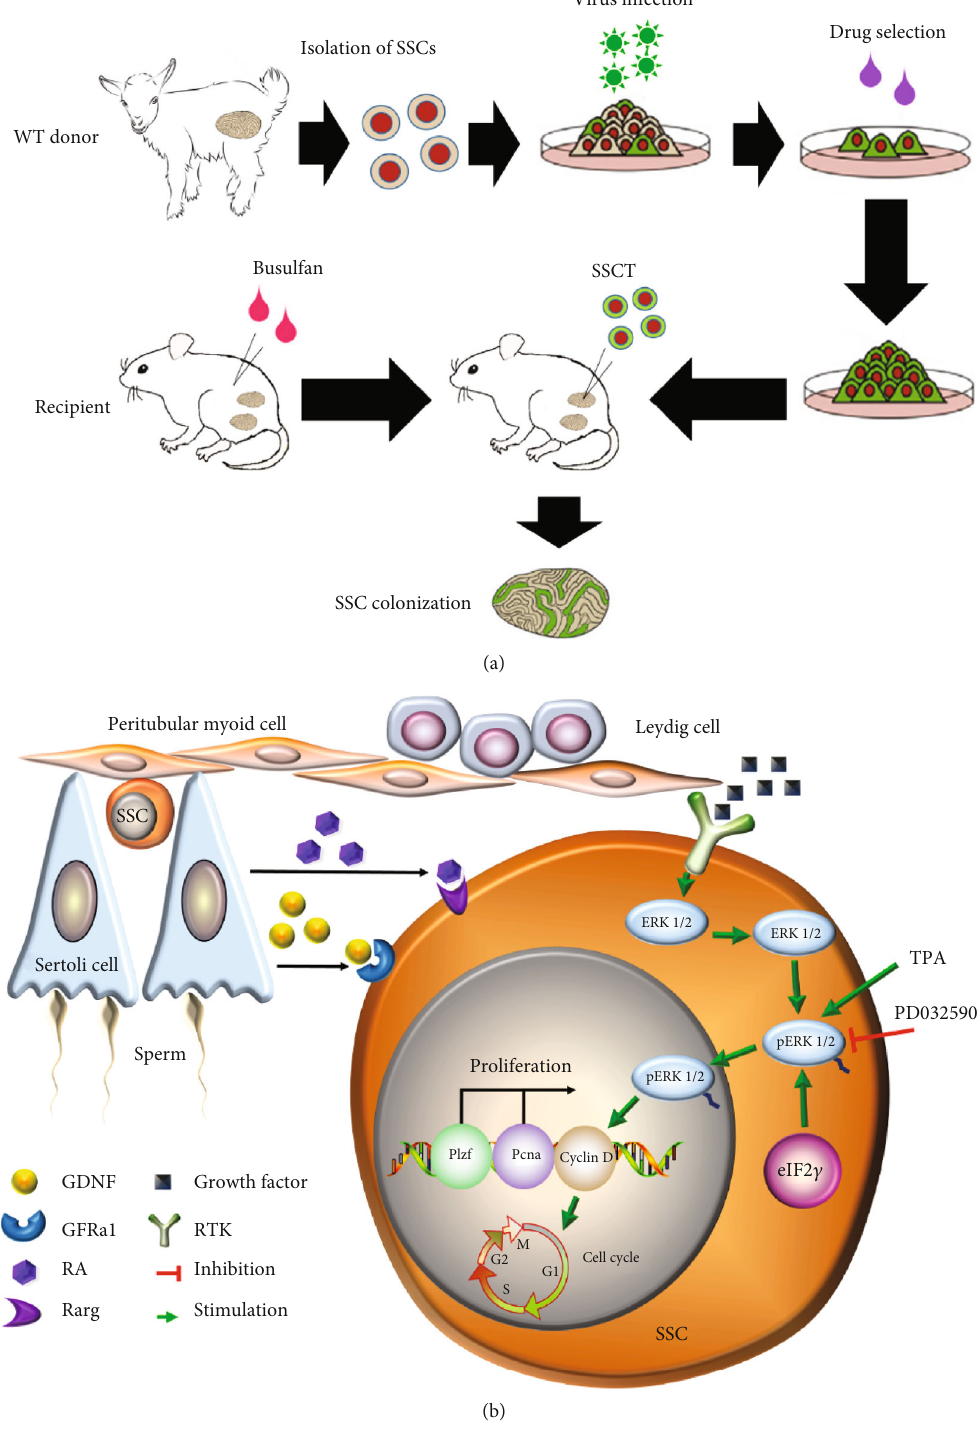
Figure 6: A schematic diagram illustrating Eif2s3y functions in goat SSCs. (a) Schematic diagram of seminiferous tubule transplantation. (b) A proposed model for Eif2s3y activating the downstream ERK signaling pathway to regulate proliferation genes in goat SSCs. This fi nding may provide an important basis for future works regarding male spermatogenic cell restoration in large